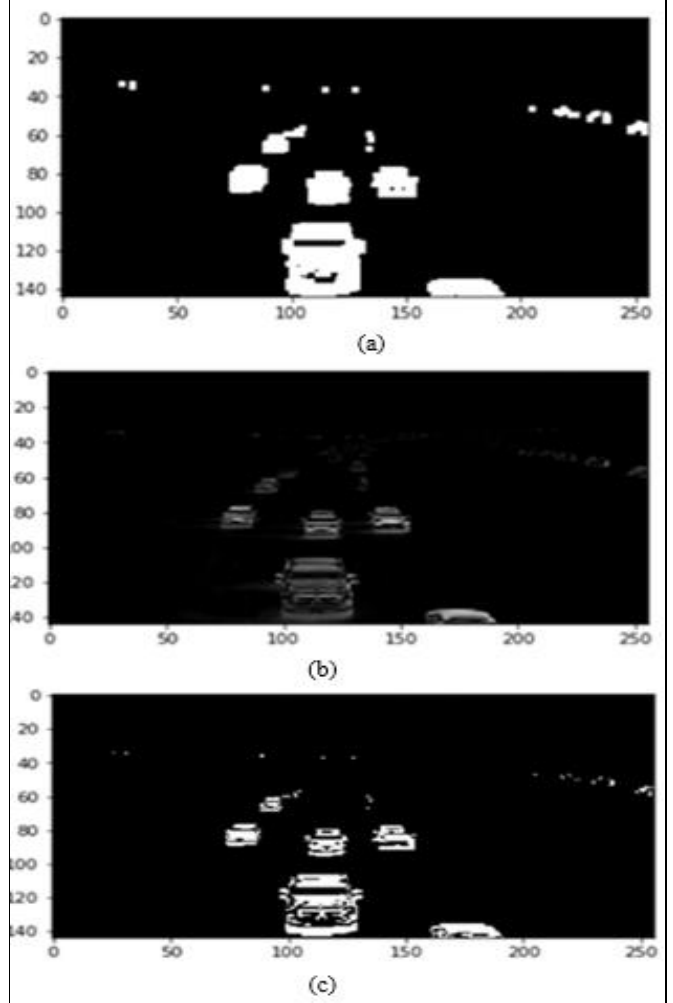
Figure 4: Image processing technique result (a) Grey image (b) Threshold image (c) Dilated image. Source: Authors, (2020).